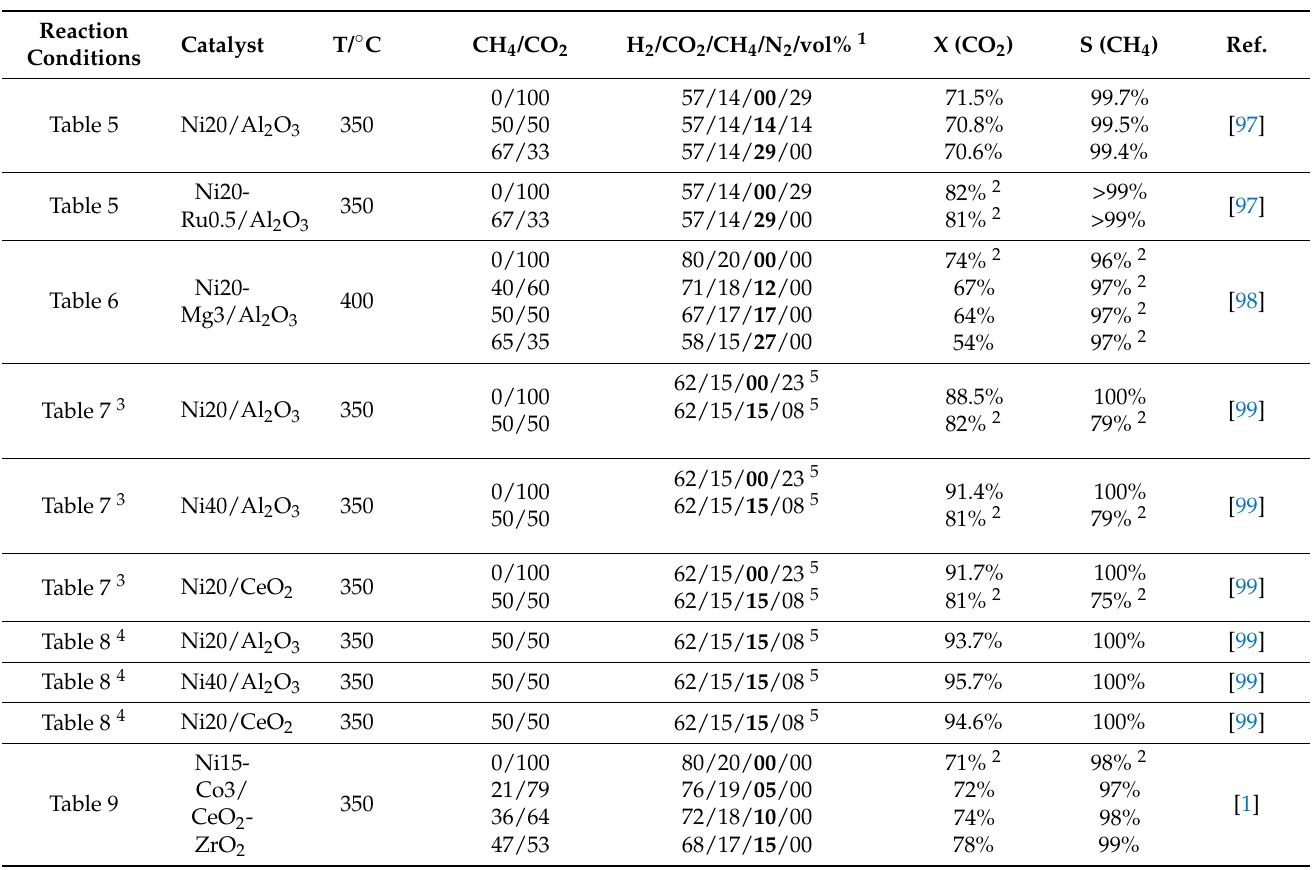
Table 4. Experimental conditions (catalyst composition, temperature, CH 4 /CO 2 ratio, and feed gas composition with CH 4 concentration in bold type) and results (CO 2 conversion and CH 4 selectivity) of different studies. All experiments were performed at 1 bar except where indicated.